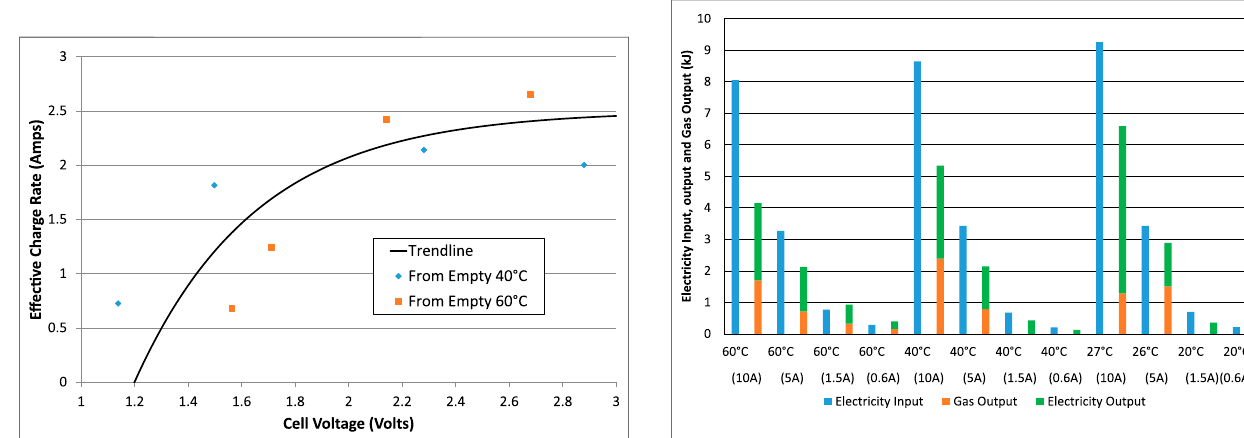
FIGURE11| Effective chargerateduring electrolysistests thatstartwith an empty cell. Asymptotic trend line added.